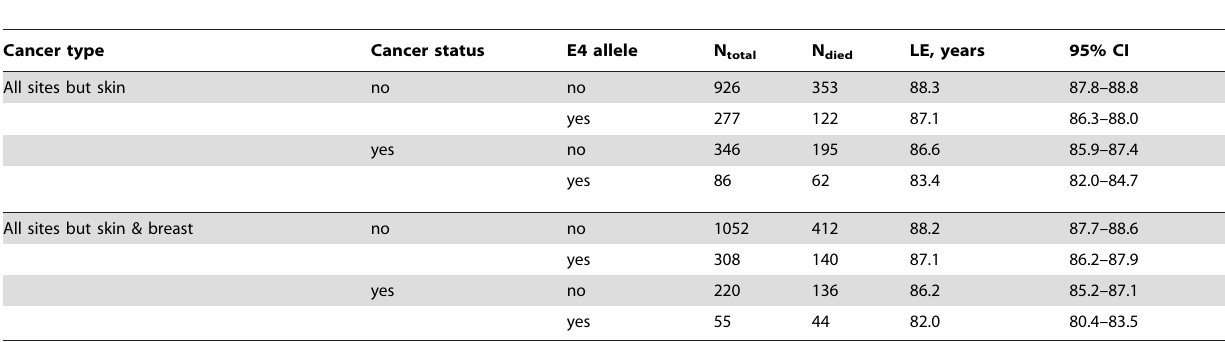
Table 4. Kaplan-Meier estimates of life expectancy of the FHS and FHSO women from the more homogeneous group who were aged between 70 and 95 years at death or the end of follow up in 2008 stratified by cancer and the ApoE4